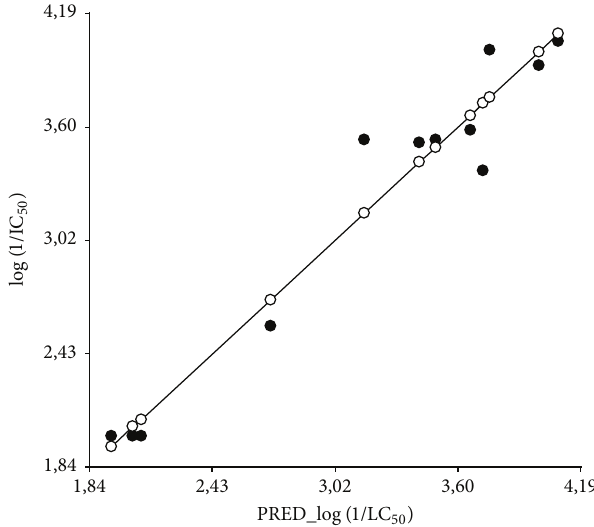
Figure 4: Multiple linear regression analysis (MLR) calculated to examine quantitative relationships between linear combinations of the dependent variable log (1/LC 50 ) and the predictor variables (structure and molecular properties). Plot of calculated versus experimental log (1/LC 50 ) of repellent activity of alcohol and phenol compounds against cockroaches.